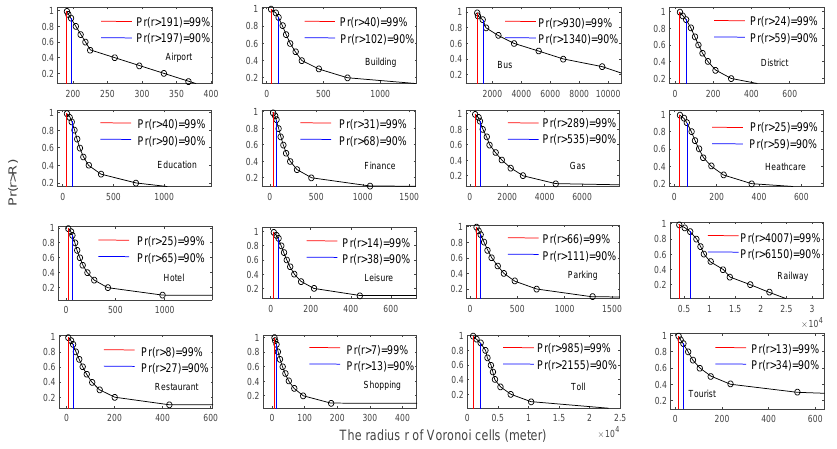
Figure 8. The cumulative distribution of the service radius r with respect to the type of POI.